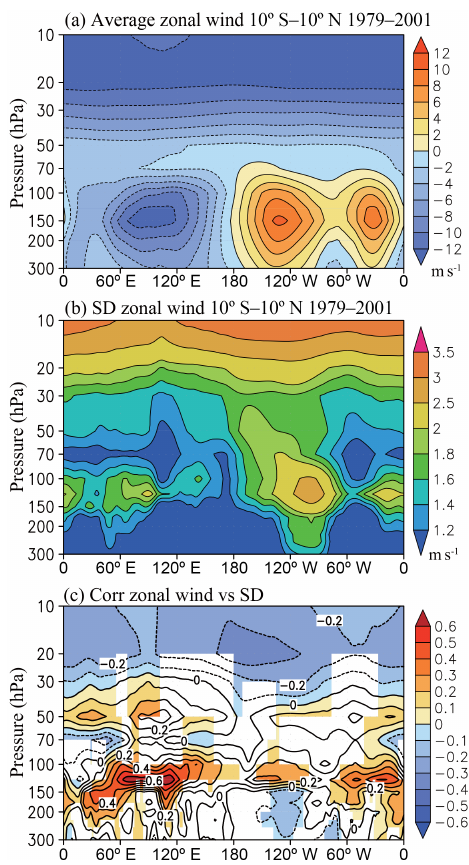
Figure 7. Longitude–height cross section of (a) averaged zonal wind in the five reanalyses, (b) the standard deviation among reanal- ysis, and (c) the correlation between absolute value of zonal wind and the standard deviation in 10 ◦ N–10 ◦ S averaged from 1979 to 2001. The color intervals are (a) 2ms − 1 , (b) 0.2ms − 1 for values less than 2ms − 1 and 0.5ms − 1 for values more than 2ms − 1 , and (c) 0.1, with statistical significance of ≥ 95%